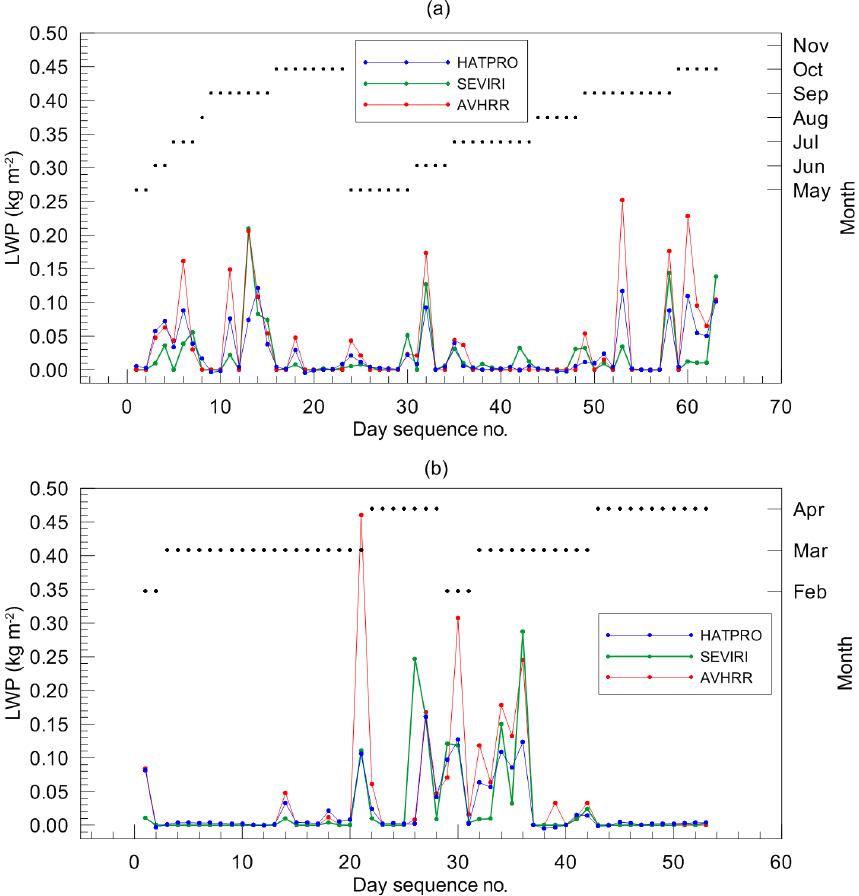
Figure 5. The LWP values obtained by HATPRO (HAT 60 , blue dots), SEVIRI (green dots), and AVHRR (red dots) as a function of day sequence number for the WH and CD seasons ( a and b respectively). Colour dots are connected by lines only for demonstrative purposes. Black dots in combination with the right y axis indicate the month of